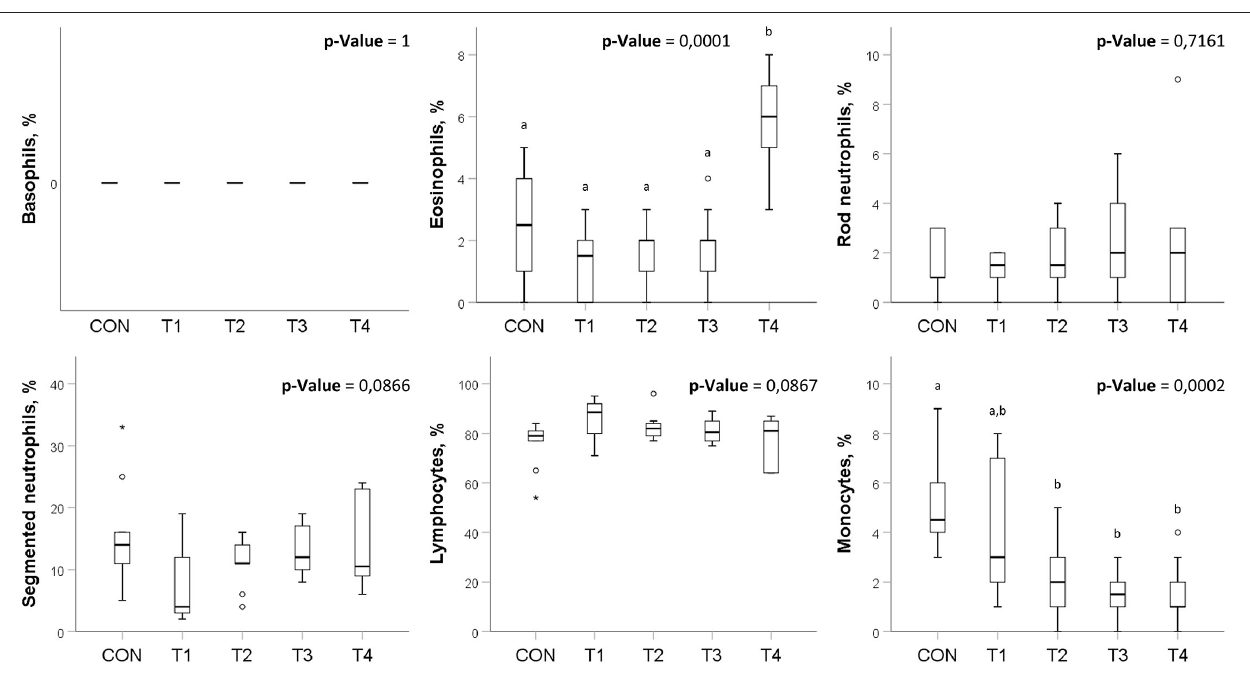
FIGURE 2 | Leukocyte formula presented as boxplots in broilers treated with probiotics. Means within the same row without common superscripts are significantly different ( p < 0.05). CON, control group; T1, group treated with B. subtilis KATMIRA1933; T2, group treated with B. subtilis KB16; T3, group treated with B. subtilis KB41; T4, group treated with B. amyloliquefaciens KB54. The data was obtained from two birds per replicated with 8 birds per group in